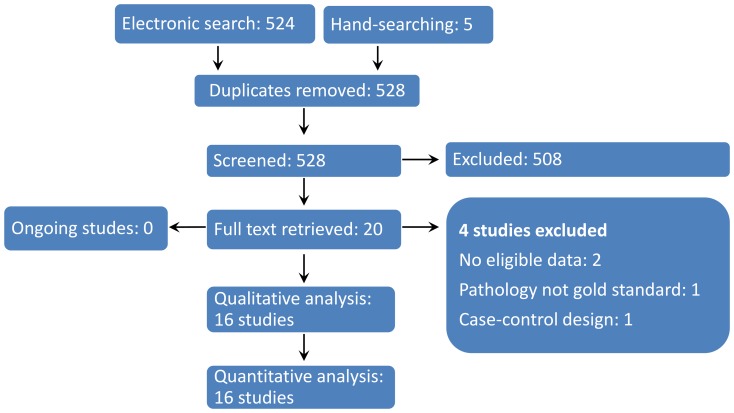
Flow diagram of study inclusion.